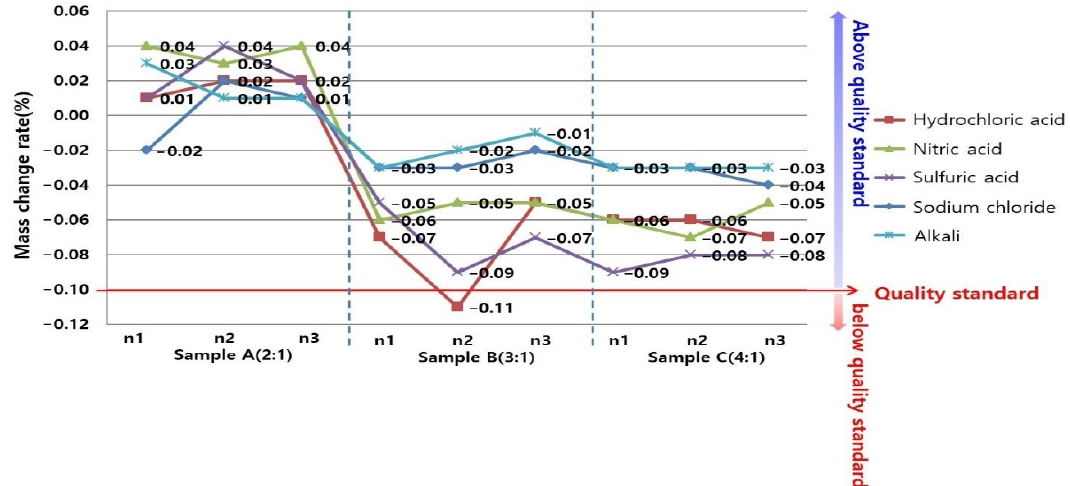
Figure 12. Chemical resistance safety by sample of W-SPRG.